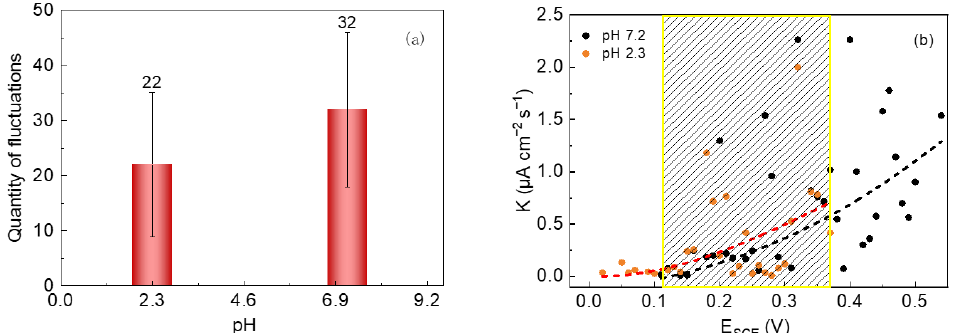
Figure 9. The number of current fluctuations ( a ) and the average growth rate of metastable pits ( b ) of 304 SS in 0.6 mol/L NaCl solutions (pH 2.3 and